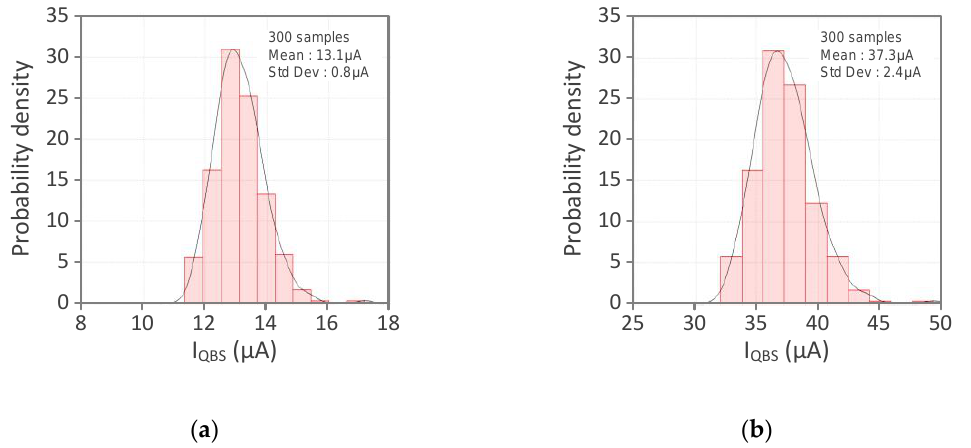
Figure 7. Monte-Carlo simulation results of the quiescent current consumption of conventional high-side UVLO based on the resistive divider (Figure 2b). ( a ) V BS = 5 V. ( b ) V BS = 20 V.